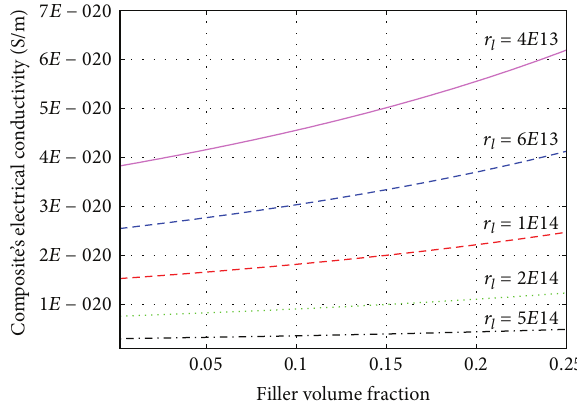
Figure 10: DC electrical conductivity of the nanocomposite when the critical exponent of the percolation is varied (McLachlan’s model).